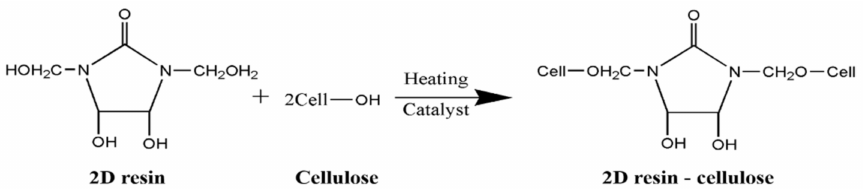
Scheme 2. Proposed crosslinking mechanism between 2D resin and